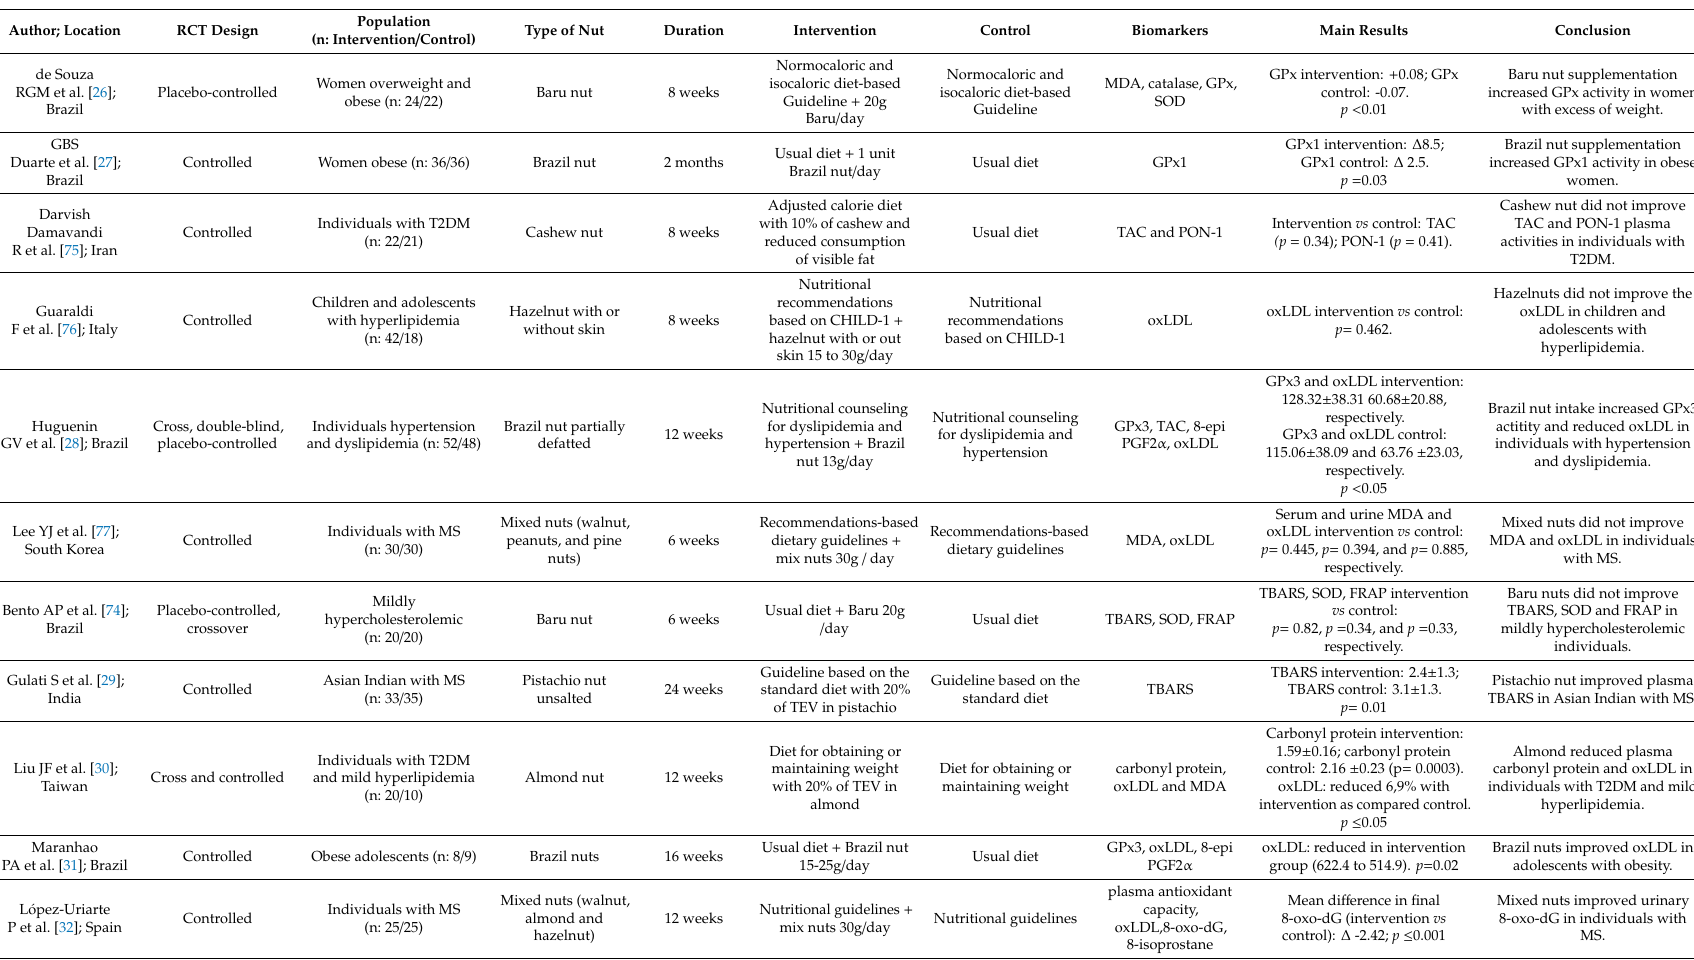
Table 4. Randomized clinical trials on nuts and oxidative stress biomarkers in primary cardiovascular